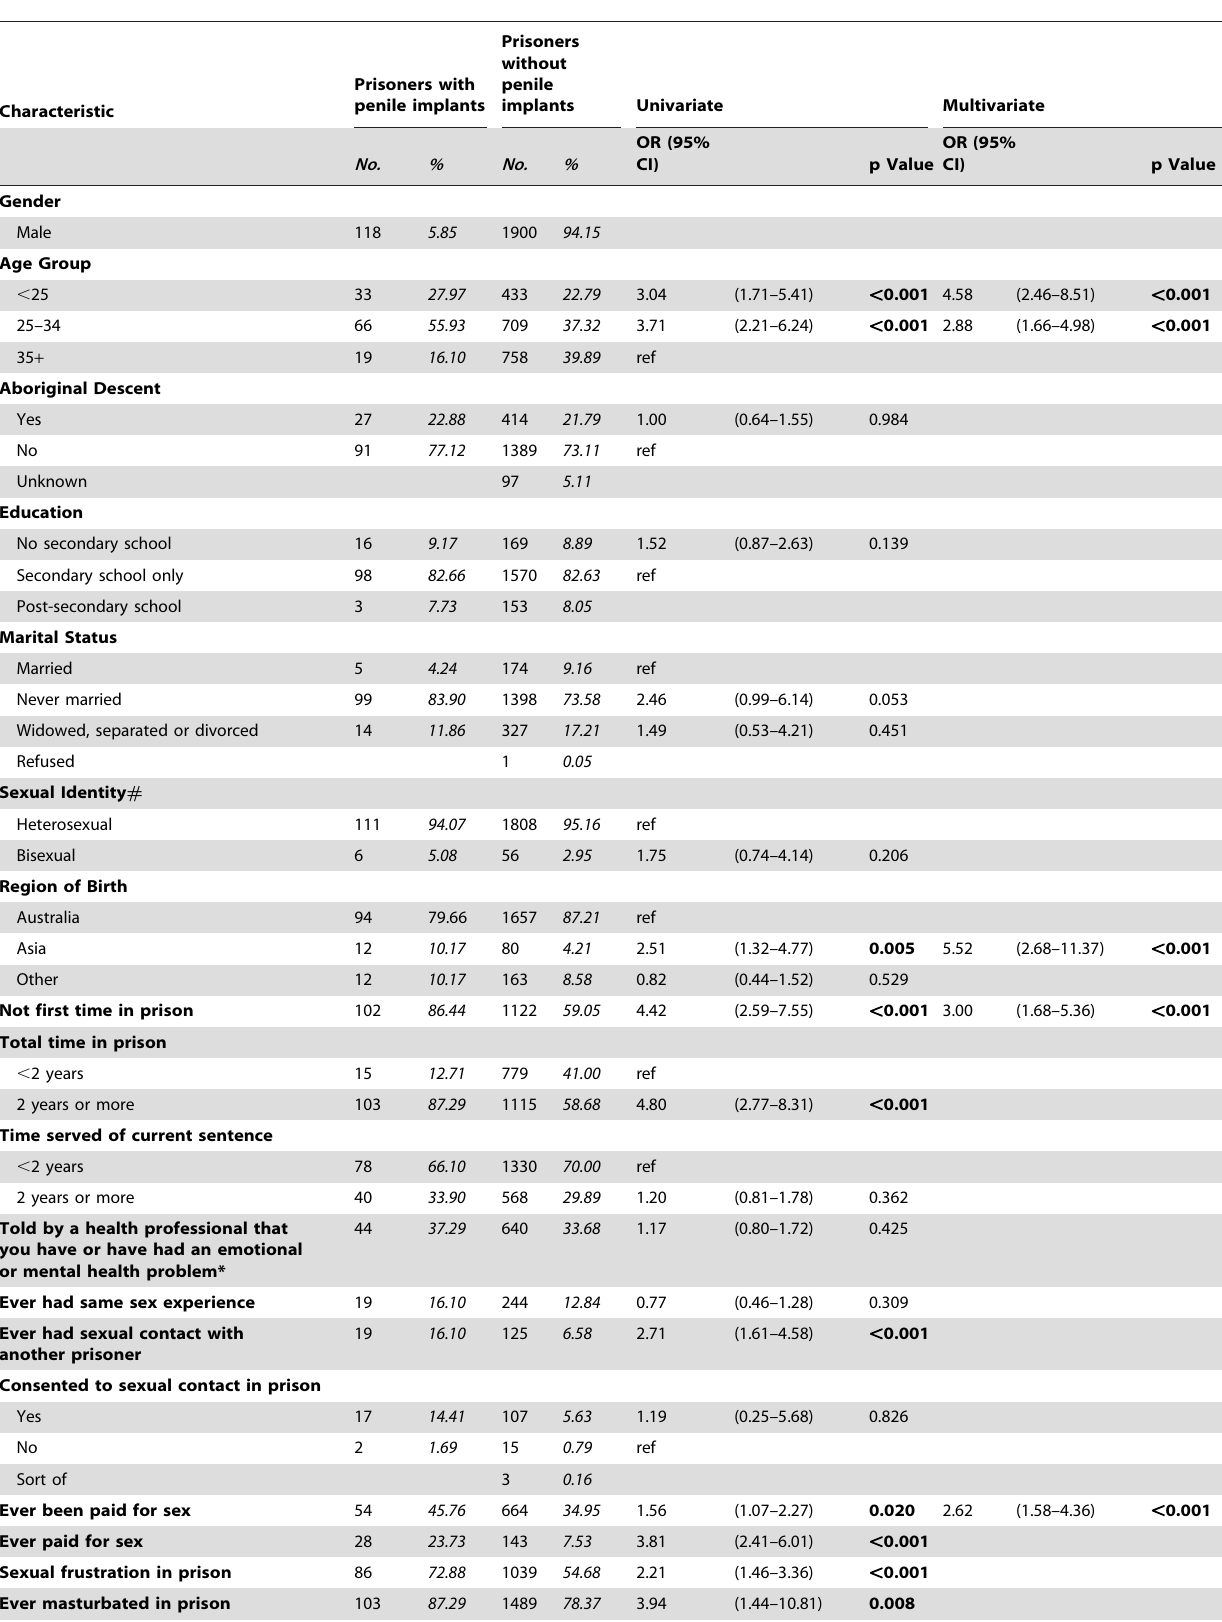
Table 1. Comparison of male prisoners in New South Wales and Queensland with and without penile implants.